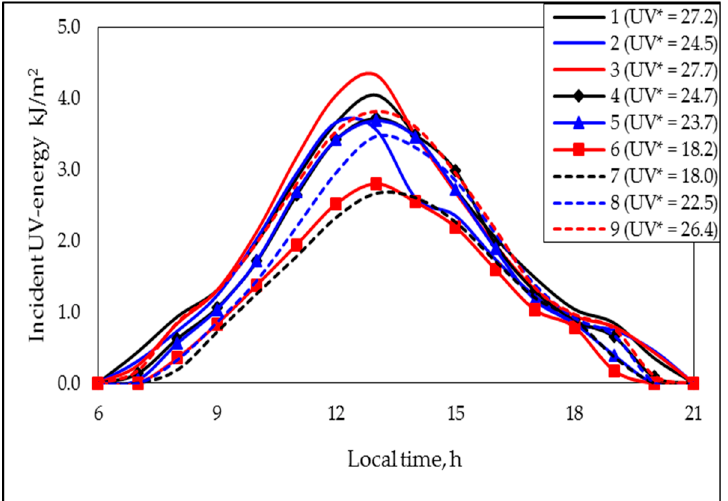
Figure 2. Representative incident UV energy profiles and UV energy (UV*) values, corresponding to the indicated degradation periods (see codes in image; the UV* values were expressed in (kJ)(h) / m 2 ).